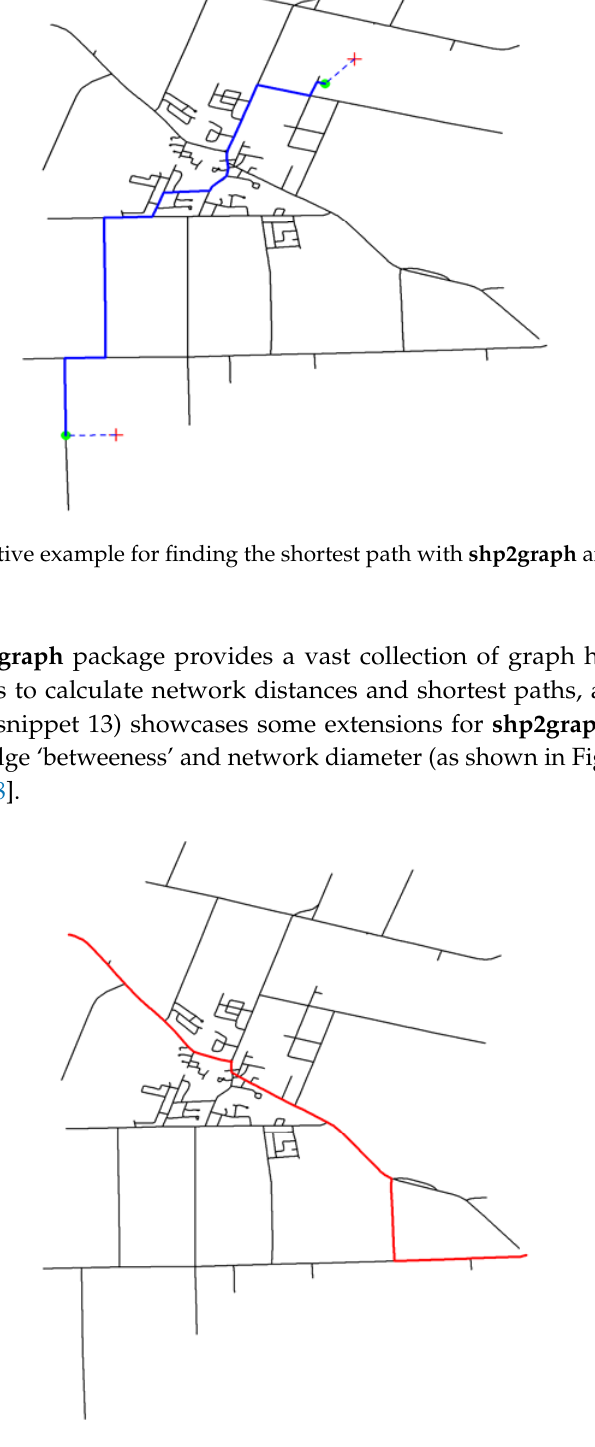
Figure 15. Finding the network diameter with shp2graph and igraph (Ontario road data).